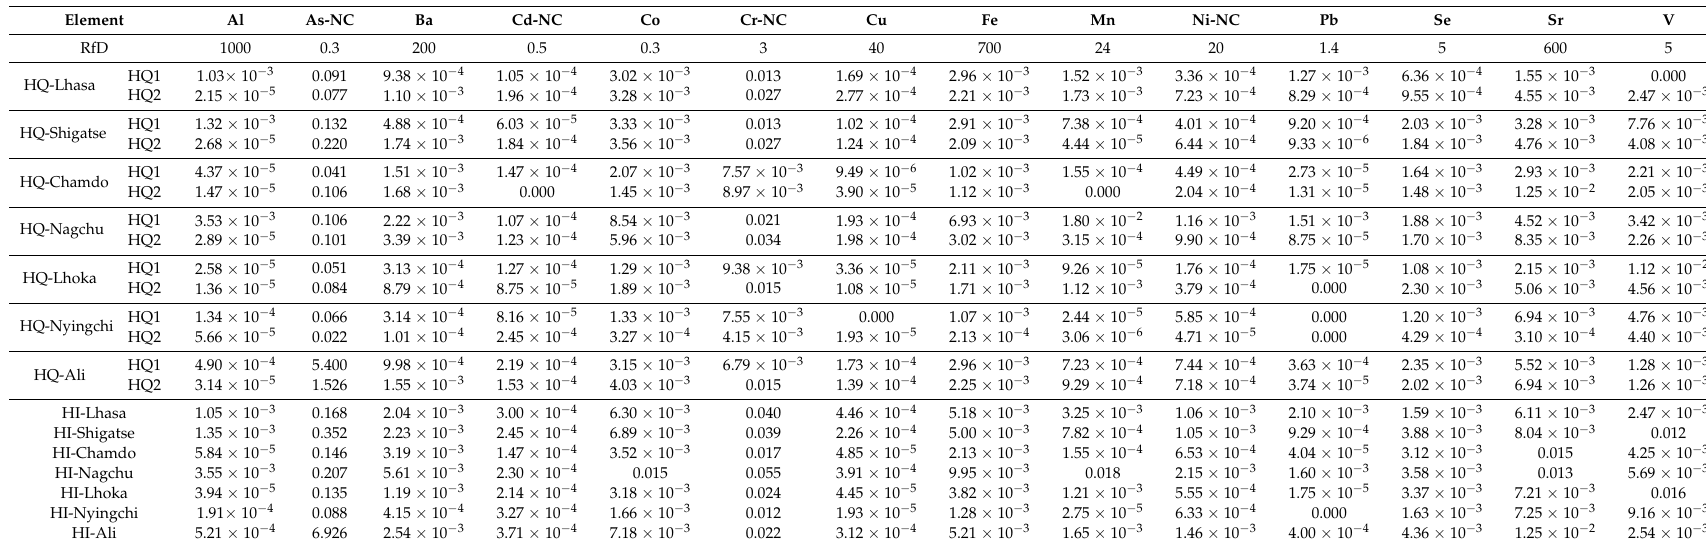
Table 3. The hazard quotient and hazard index of Tibet’s natural water in different